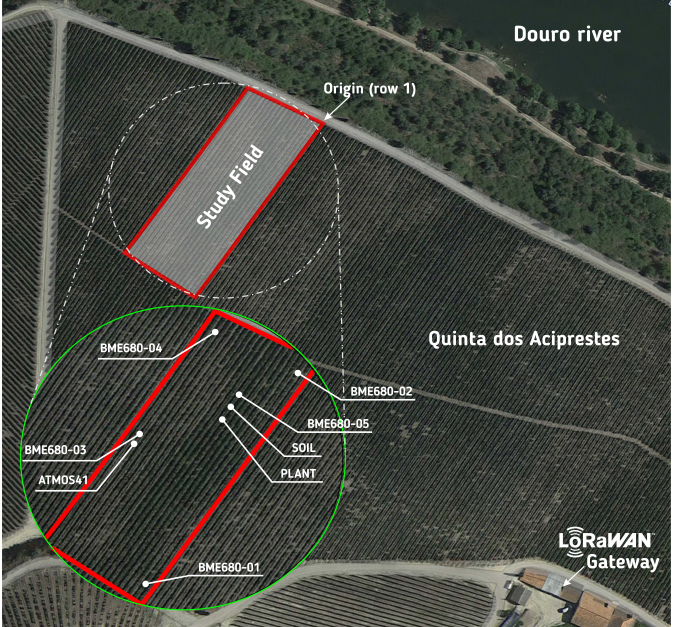
Figure 5. Location of the study field, delimited in red. Inset shows a zoom of the field of study, in which it is possible to see the location of the eight LoRaWAN modules. The gateway is situated about 300m from the study field. Satellite imagery courtesy of Google